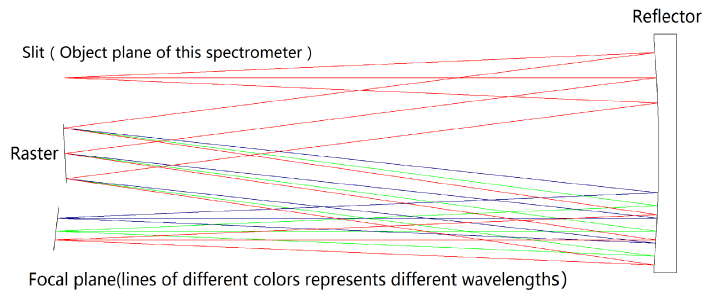
Figure 2. The E-F structure imaging spectrometer.